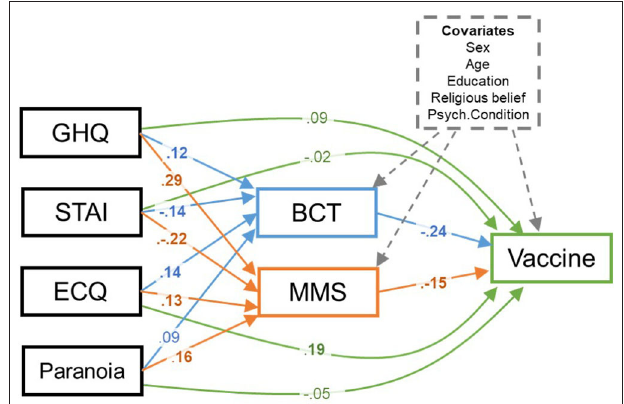
FIGURE 3 | The structured equation model tested. Standardized coefficients are reported only for direct paths. Coefficients for significant paths were reported in the boldface. Indirect effects are reported in text. BCT, belief in conspiracy theories; MMS, mistrust in medicine and science; Vaccine, propensity to get